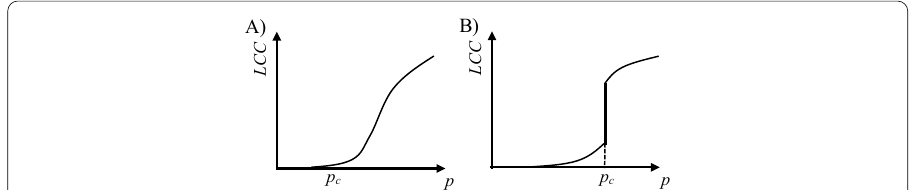
Fig. 1 Schematic behavior of the size of the LCC as a function of the proportion of remaining nodes p during a node removal process: A LCC shows a continuous 2nd order decreases without abrupt decrease and B LCC shows an abrupt decrease in correspondence of p p c . The node attack strategy in B is able to dismantle = the network with a smaller proportion of removed nodes, i.e. is the most effective to decrease the LCC , thus individuating the most important nodes in